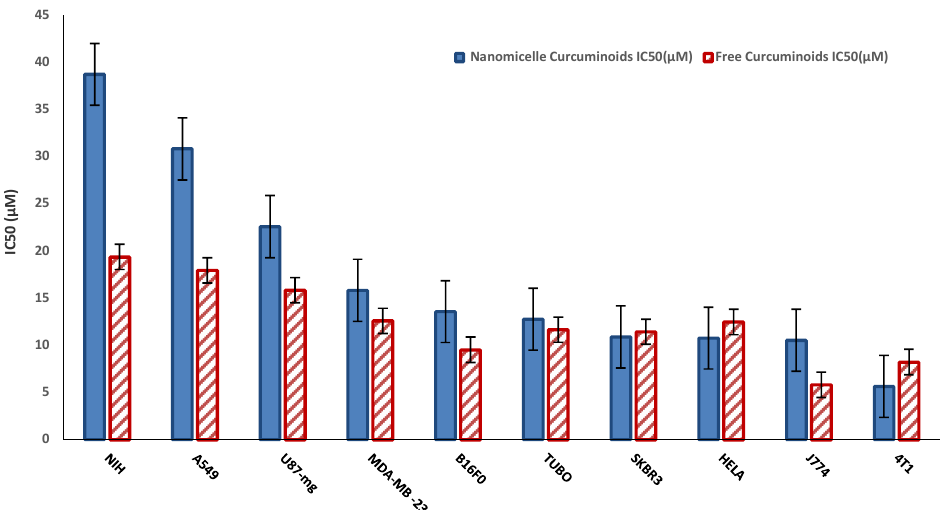
Fig. 1. Normal and cancer cells Half maximal inhibitory concentration (IC50; µM) of free and nanomicelle form of curcuminoids after the 48-hour incubation period (**: P-value <0.01).